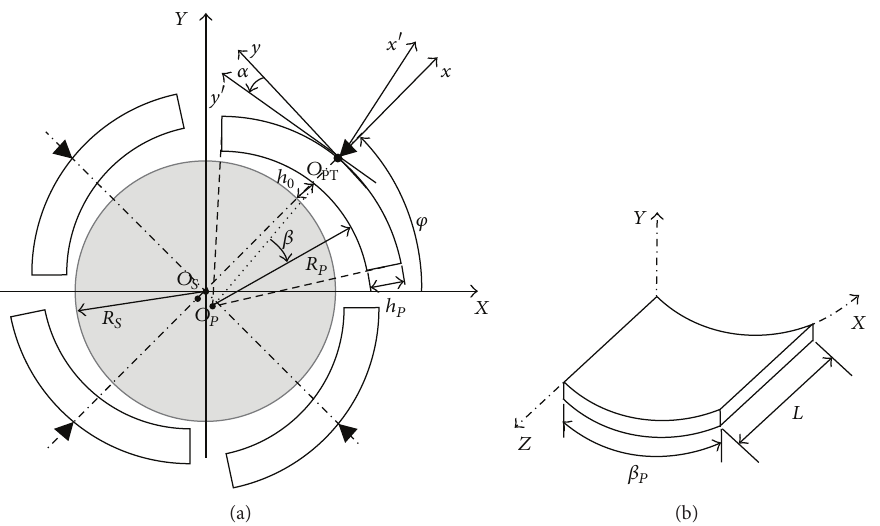
Figure 1: Schematic representation: (a) front view of the rotor bearing; (b) perspective view of the pad.